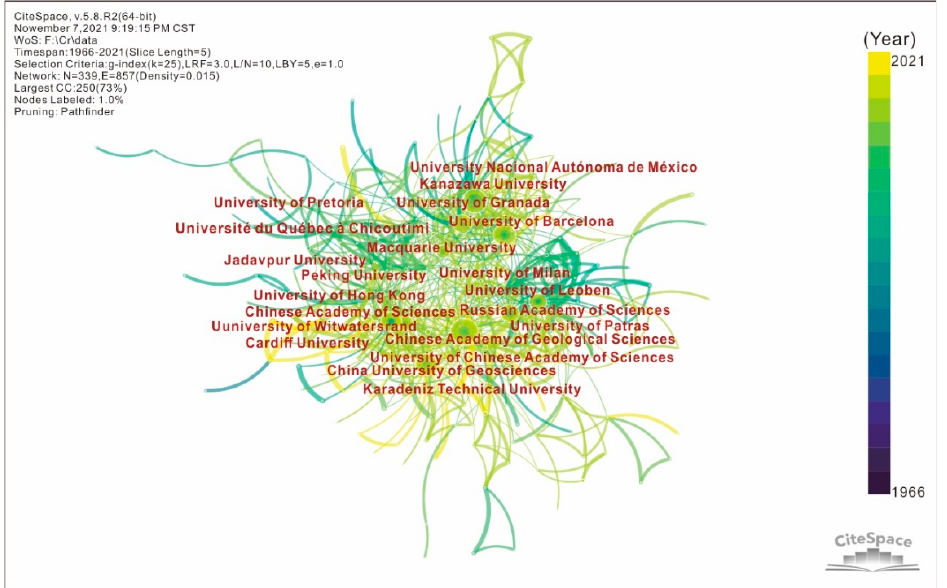
Figure 3. Co-occurring institutions map. Table 2. Top 20 institutions ranked by the number of publications with a focus on chromitite.